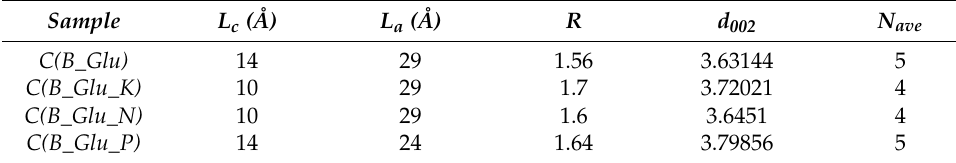
Table 1. Structural parameters for the synthesized carbons.